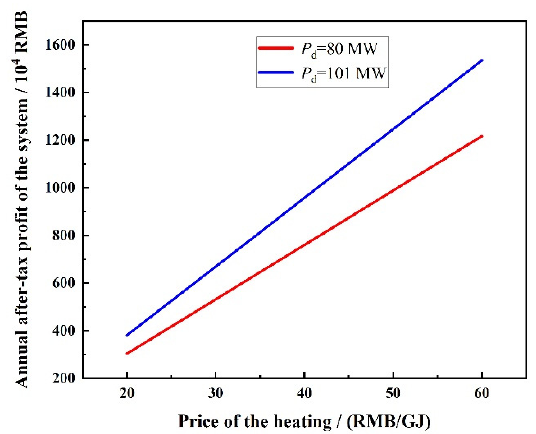
Figure 14. Annual after-tax profits vs. the price of heating.